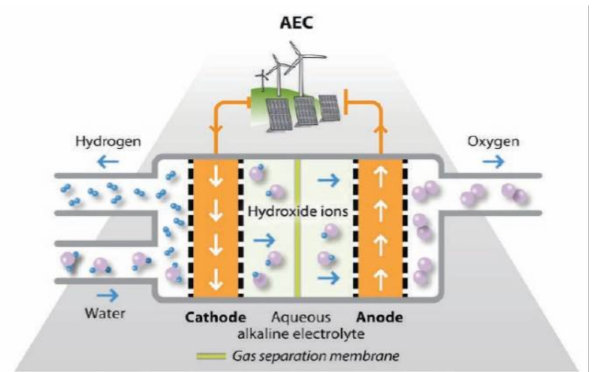
Figure 1. Alkaline Electrolyser Cell (AEC) working principle. Reprinted from ref. [9] with permission. Copyright 2013